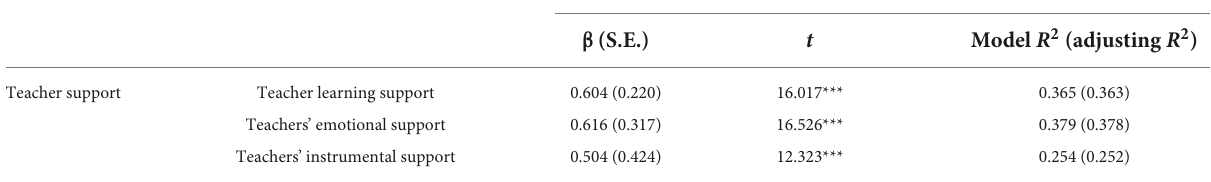
TABLE 4 Independent influence of different factors of teacher support on information literacy of higher vocational students. Variables and factors